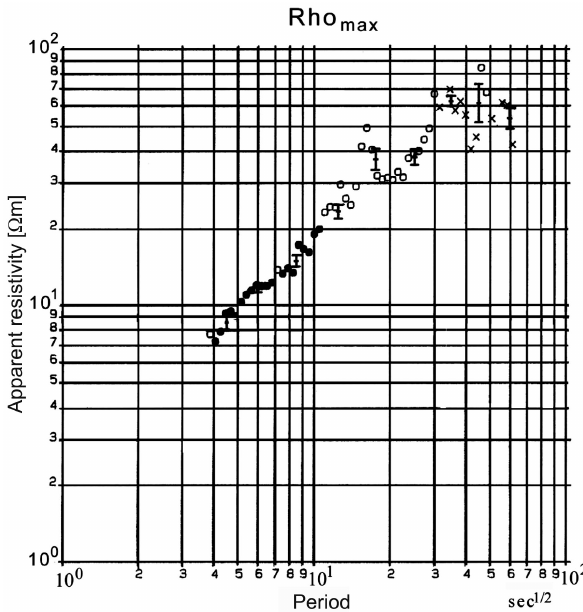
Fig. 3. MT sounding curve of NCK (Rho max ) from records around the solar eclipse, 11 August 1999. Individual points were obtained from parts of the 6-h records to illustrate the